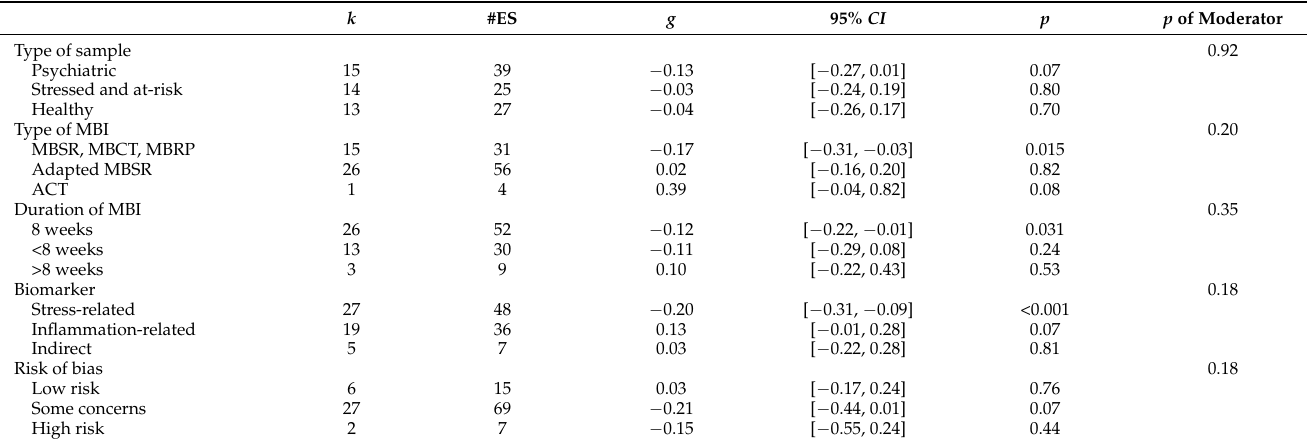
Table 4. Results of Subgroup Analyses in TLMA